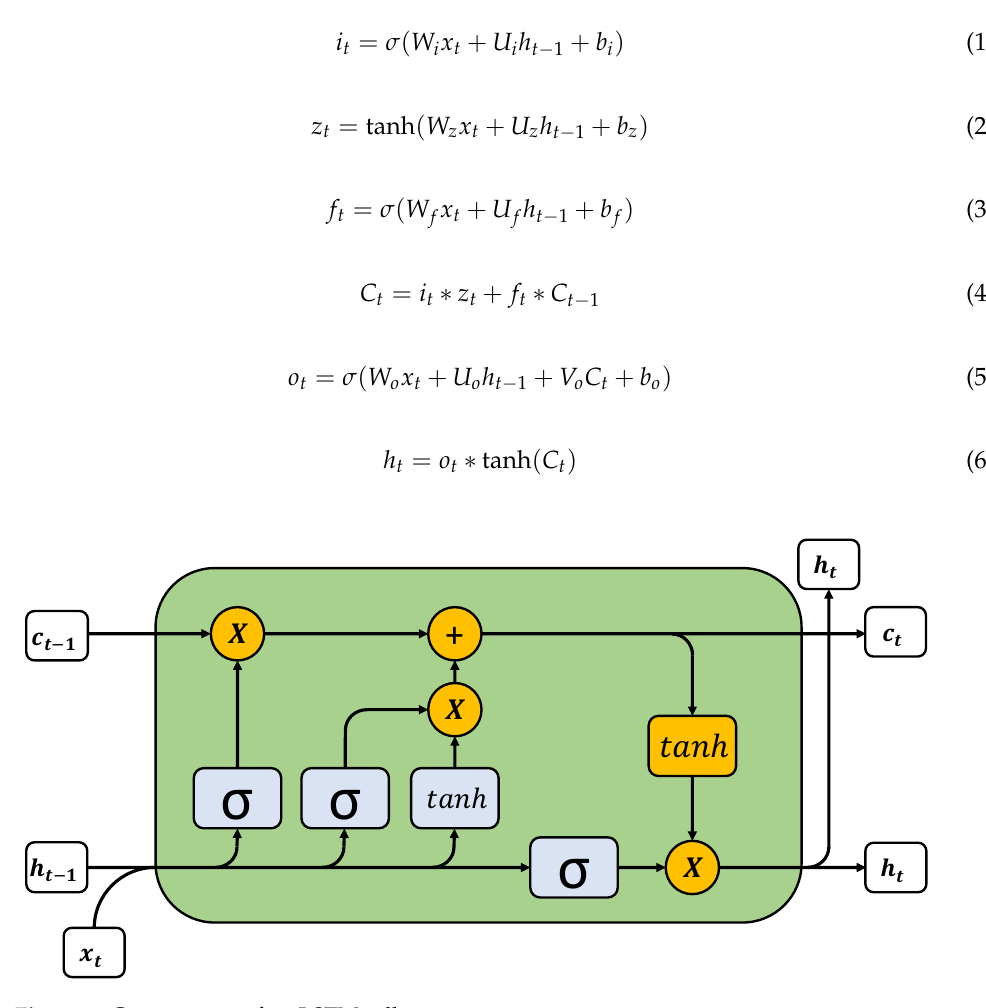
Figure 1. Components of an LSTM